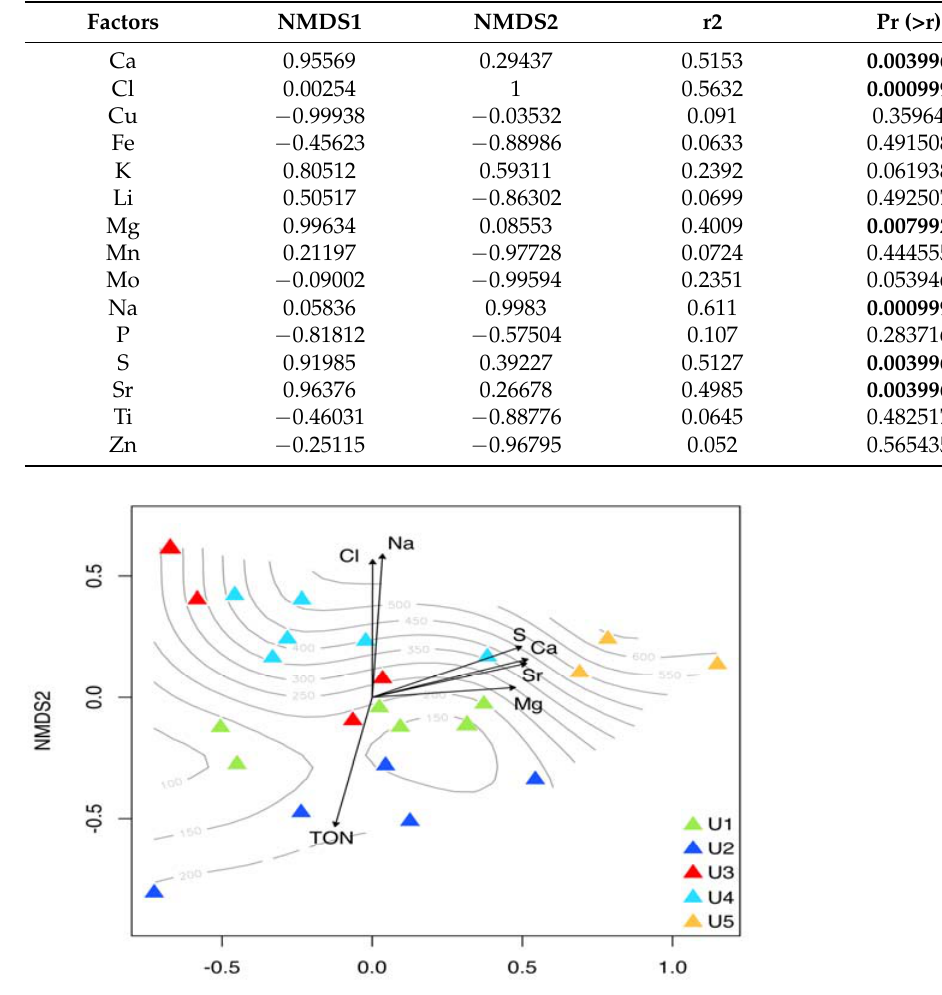
Figure 5. Non-metric multidimensional scaling (NMDS) plot based on Bray-Curtis distance of fungal communities found in the five permafrost units (U1, U2, U3, U4, and U5) (considering filamentous fungi, yeasts, and unclassified taxa). Dashed lines represent the gradient of depth. The envfit function was used to show the chemical and physical parameters affecting fungal communities. Only the signi fi cant ( p < 0.05) vectors were fi tt ed to the NMDS ordination. Table 2. Results of env fi t function showing the relationship of chemical/physical parameters with Non-metric multidimensional scaling (NMDS) ordination of the permafrost-associated fungal com- munities. TOC, total organic carbon; TON, total organic nitrogen; EC, electrical conductivity. Sig- ni fi cant ( p < 0.05) p values are shown in bold.